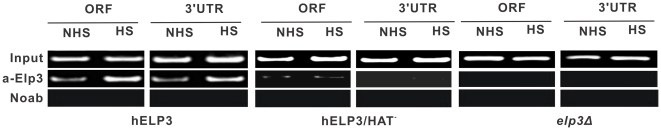
Human Elp3 participates in regulation the transcription of SSA3 in yeast and its HAT domain is essential for this function.The plasmids containing hELP3, hELP3/HAT
− were transformed into the elp3Δ strain, transformant cells were heat-shocked for 10 min at 37°C (HS), or left at 30°C (NHS), and chromatin immunoprecipitation assays with anti-hElp3 antibody were carried out. Immunoprecipitated DNA was analyzed by polymerase chain reaction using primers specific to the open reading frame (ORF) and 3′ untranslated region (UTR) of the SSA3 gene. Products were analyzed by agarose gel electrophoresis followed by ethidium bromide staining. Input: total input DNA or sonicated genome DNA as template, The “input” sample is an aliquot of chromatin that has not been immunoprecipitated but has been crosslinked, sonicated, and processed in a manner identical to the experimental samples; a-hElp3: hElp3 antibody immunoprecipitated DNA as template; NoAb: primary antibody was omitted.